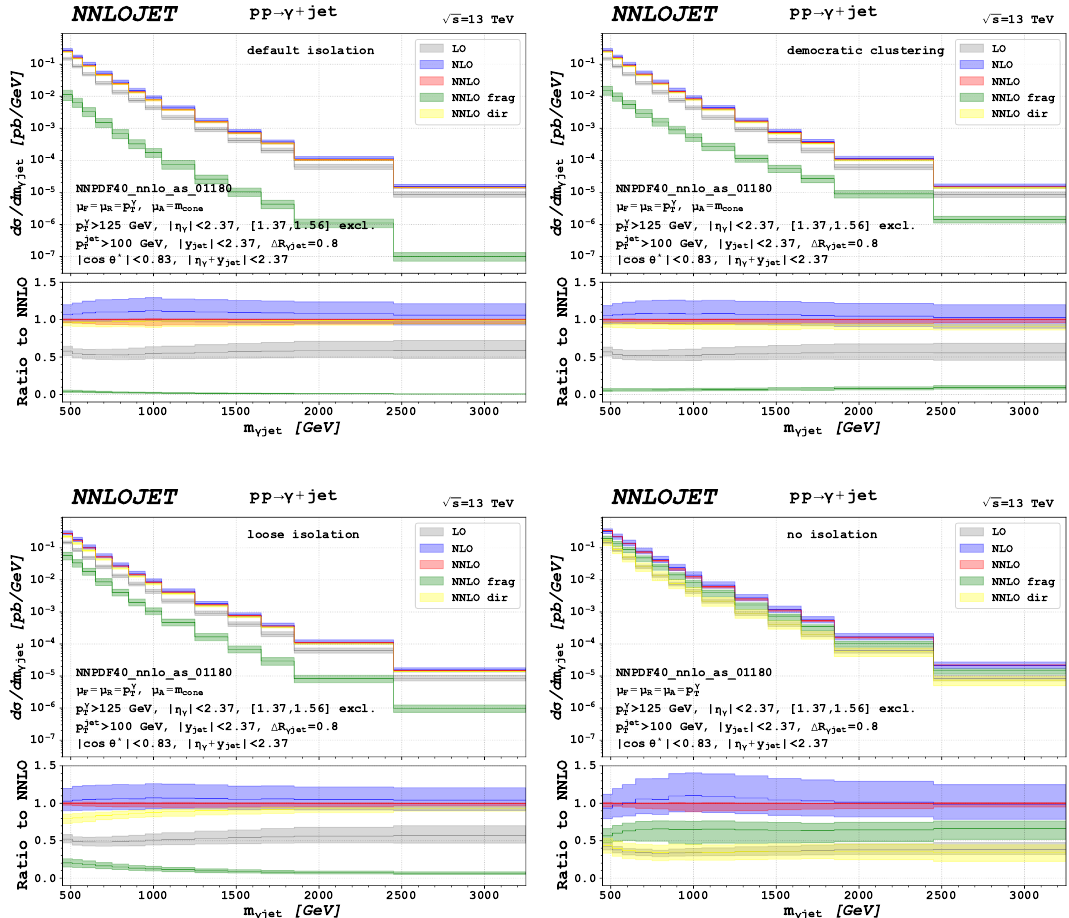
Figure 14. Decomposition of the cross section differential in the photon-jet invariant mass. Results obtained with the default isolation, a loose isolation, democratic clustering and without isolation are